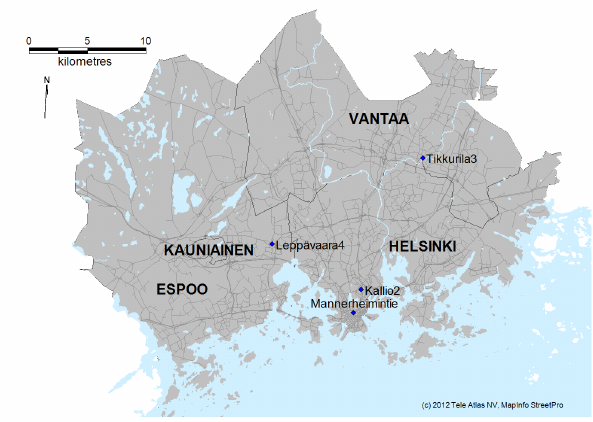
Figure 1. The cities in the Helsinki Metropolitan Area (Helsinki, Espoo, Vantaa and Kauniainen) and the selected four measure- ment stations. The geographical extent of the area is approximately 35 ×